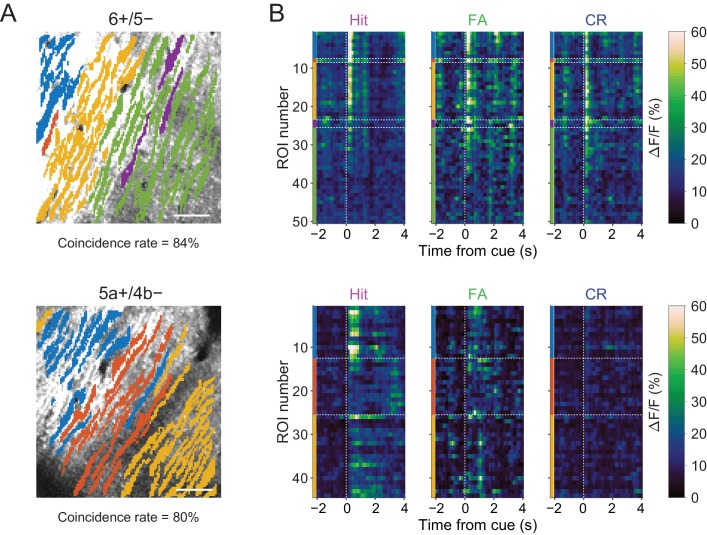
Task-related CF signals in individual clusters.(A) Projection of clustering results of Figure 2—figure supplement 2A overlaid on tdTomato images at 6+/5− (top) and 5a+/4b− (bottom) boundaries. Coincidence rates of clustering results and AldC expression are indicated below the images. (B) Trial-averaged single ROI calcium traces separated on the basis of clustering results. Colored bars indicate ROIs from colored clusters in panel (A). Horizontal dashed lines represent the boundaries of clusters. Vertical dashed lines represent cue onsets.